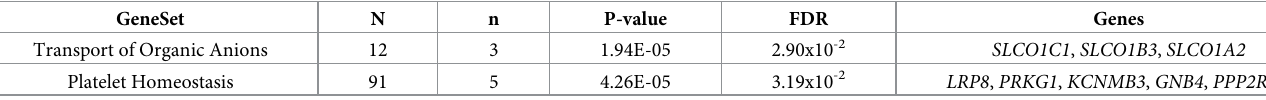
Table 3. Reactome Gene Set Enrichment Results for SNPs P < 1x10 -5 . GeneSet Platelet Homeostasis N indicates the number of genes included in the entire set while n shows the number of genes that SNPs mapped to in our data that were a part of the whole set. The FDR is the P-value for enrichment that has been corrected for the number of databases